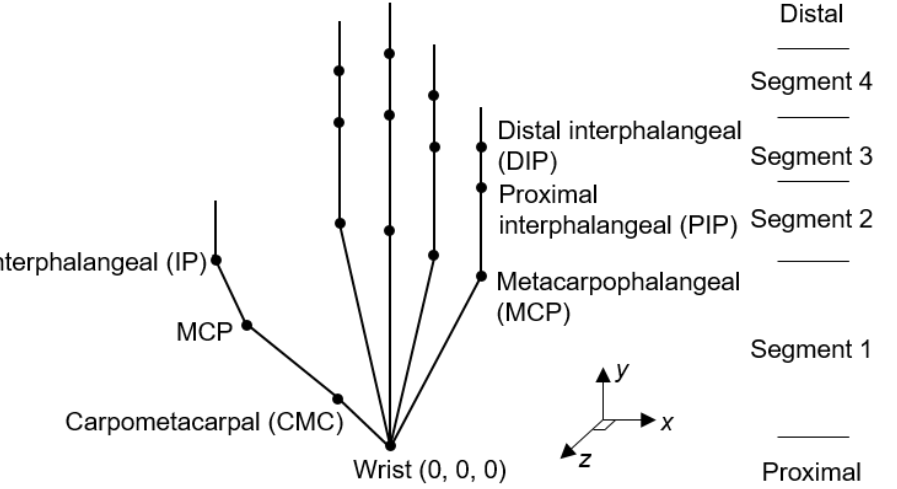
Figure 4. Linkage system of the hand. For the thumb, Segment 1 is the carpal, Segment 2 the metacarpal, Segment 3 the proximal phalangeal, and Segment 4 the distal phalangeal. For the four fingers, Segment 1 is the carpometacarpal, Segment 2 the proximal phalangeal, Segment 3 the middle phalangeal, and Segment 4 the distal phalangeal.